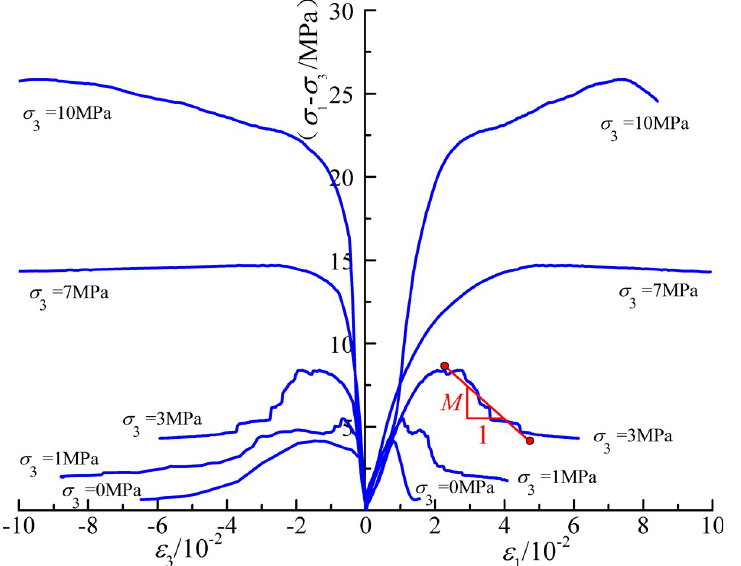
Fig 3. Full stress-strain curves of the mudstone.